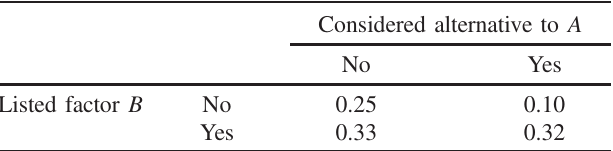
participants answering 6 scenarios